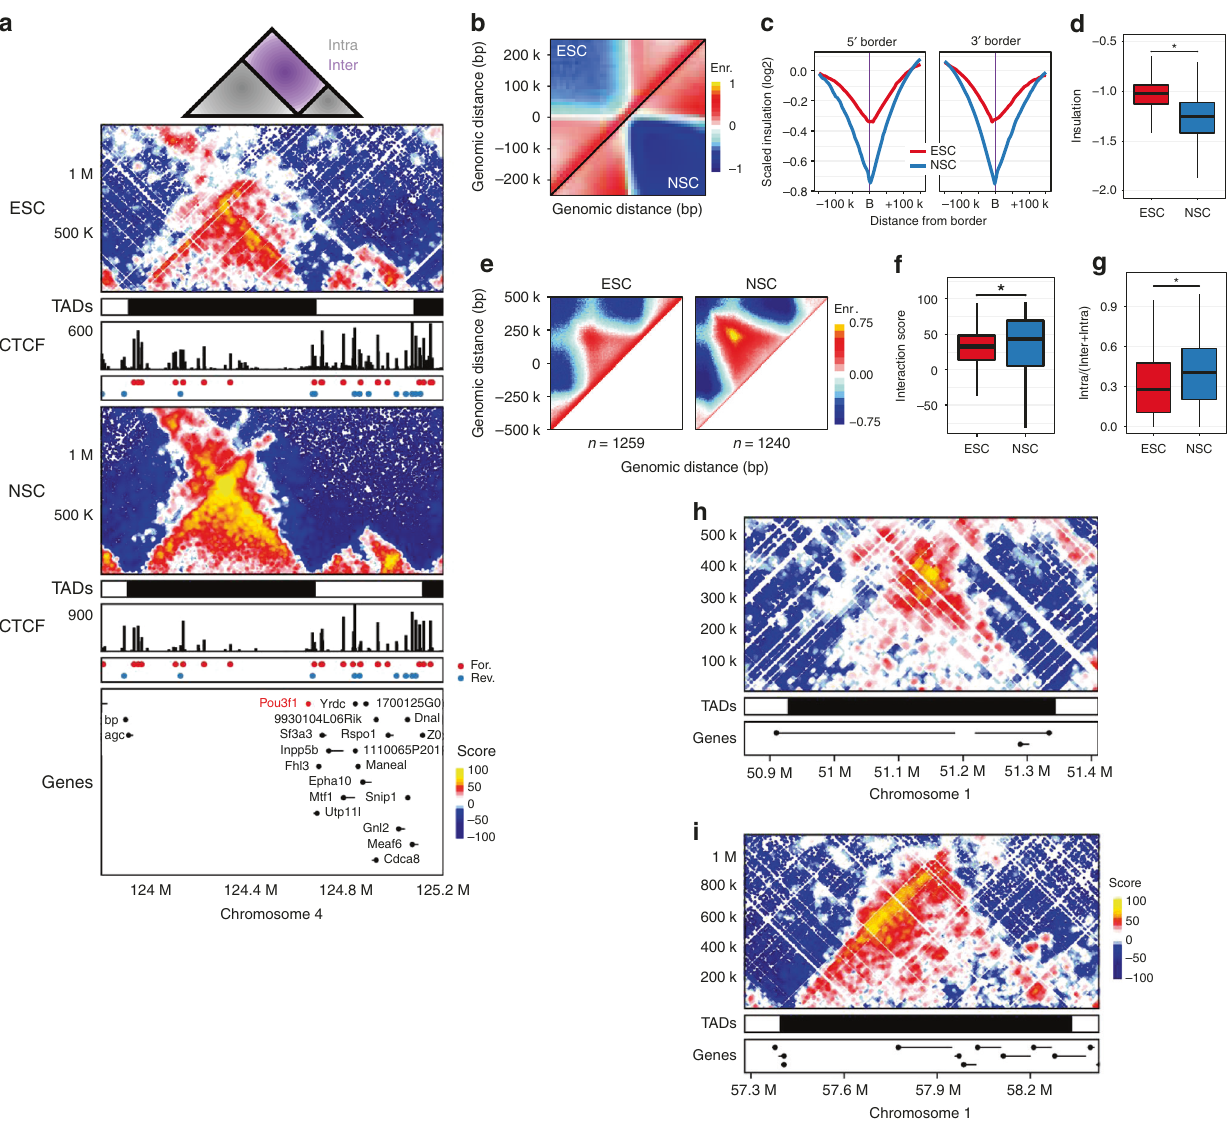
Fig. 1 Topological changes during lineage commitment. a Schematic of intra-TAD (grey) and inter-TAD (purple) interactions (top). Hi-C and CTCF ChIP- seq data for a 1.5 Mb region on chr4 around the Pou3f1 gene in ESC (upper) and NSC (middle). TADs are represented as alternating black/white rectangles and gene annotations are shown in the bottom panel. Hi-C contact maps show the interaction ‘ Scores ’ for individual fragment end pairs, colour-coded according to the density of the observed contacts around it and normalised by the density of the expected contacts (see the section “ Methods ” ). CTCF ChIP-seq tracks as well as colour-coded CTCF motifs under ChIP peaks are shown for both cell types (red and blue dots represent forward and reverse motifs, respectively). b Aggregate Hi-C maps of ESC (upper half) and NSC (lower half) TAD borders reveal increased insulation between NSC TADs. c Scaled contact insulation pro fi les across ESC (red) and NSC (blue) TAD borders at 300 kb band. d Distribution of observed insulation at borders in ESC (red) and NSC (blue). Central bar represents the median with boxes indicating the upper and lower quartiles. KS test * p < 0.001. e Aggregate Hi-C maps of size-selected (30th – 70th percentiles) TADs from both cell types showing increased interactions between TAD borders in NSC (left panel), note strong ‘ corner ’ interaction in NSCs. f Distribution of mean interaction score between 20 kb regions centred on intra-TAD border pairs in ESC and NSC (right panel). Box plot as in d . g Distribution of TAD connectivity de fi ned as the number of high-score contacts (>40) that are located within a TAD as a proportion of high-score contacts that connect the TAD to a 10 Mb region up or downstream of the TAD. Box plot as in d . h , i Examples of TAD types observed in ESC Hi-C data; h TAD with a prominent interaction between the TAD borders (loop domain) and ( i ) TAD with an asymmetric contact pro fi le ‘ anchored ’ on the 5 ′ border (5 ′ stripe domain). Shown also are the TAD positions and gene annotations as in ( a